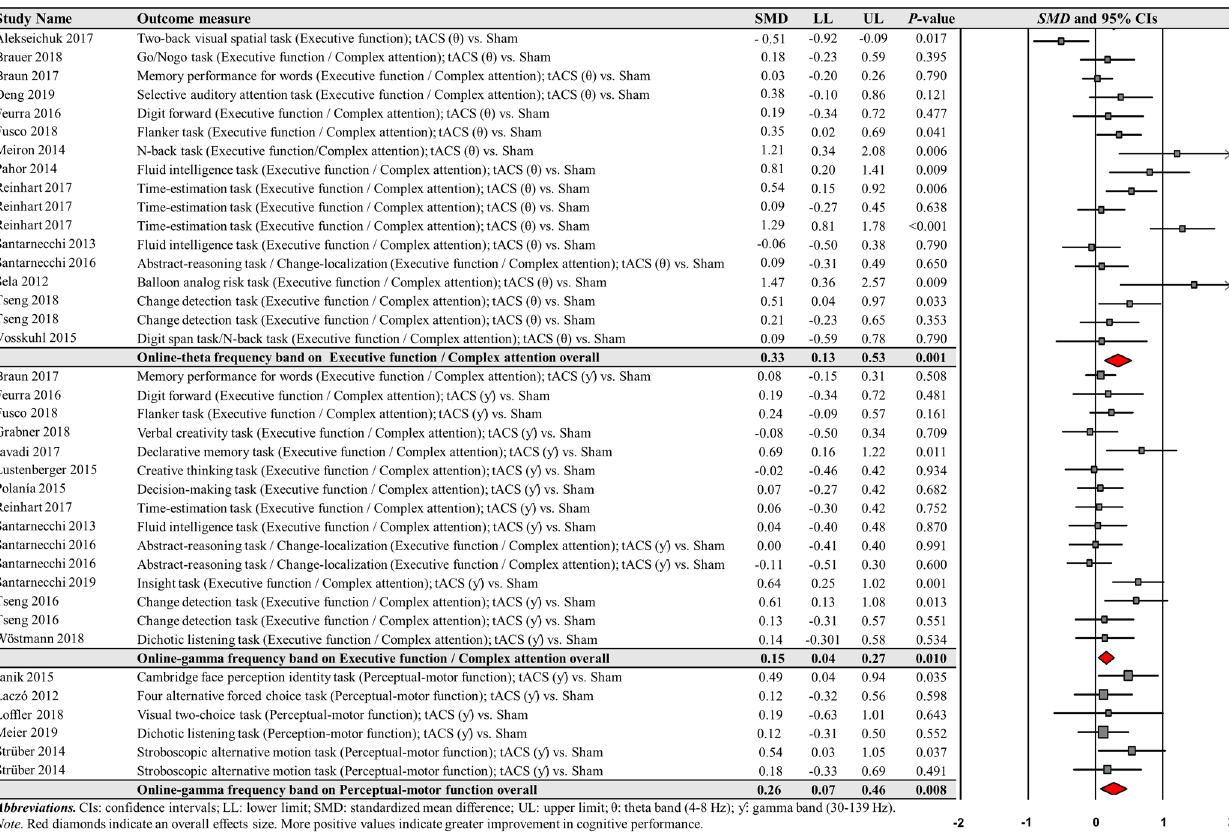
Fig. 8 Cognitive performance comparisons after online-tACS with theta and gamma frequency bands across cognitive domains. Meta- analytic fi ndings show potential effects of online-tACS protocols with theta frequency band on changes in executive function / complex attention and online-tACS protocols with gamma frequency band on changes in executive function / complex attention and perceptual- motor function.